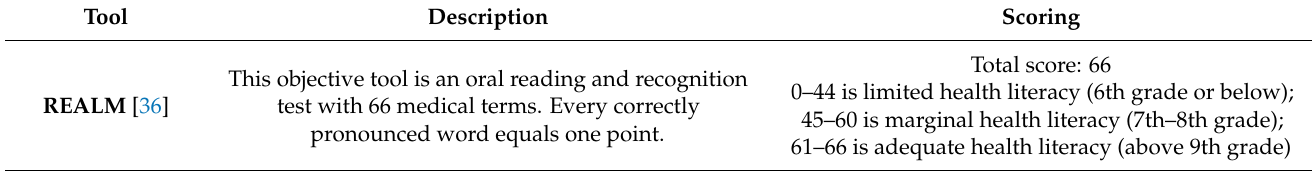
Table 3. Tools used in the